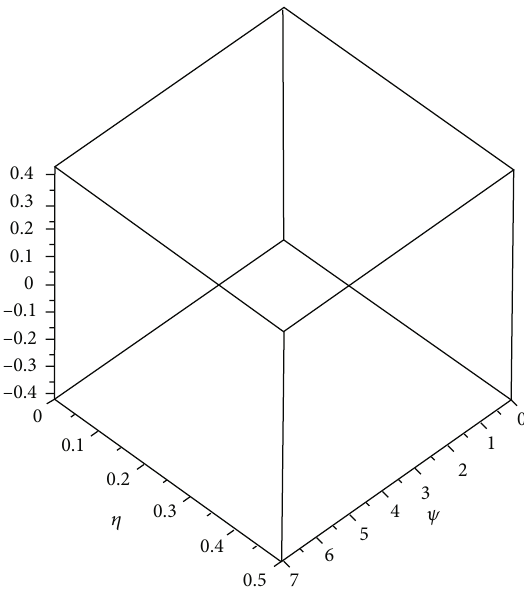
Figure 7: The fi rst graph shows the fuzzy 3D upper and lower fi gure of the various fractional orders of γ